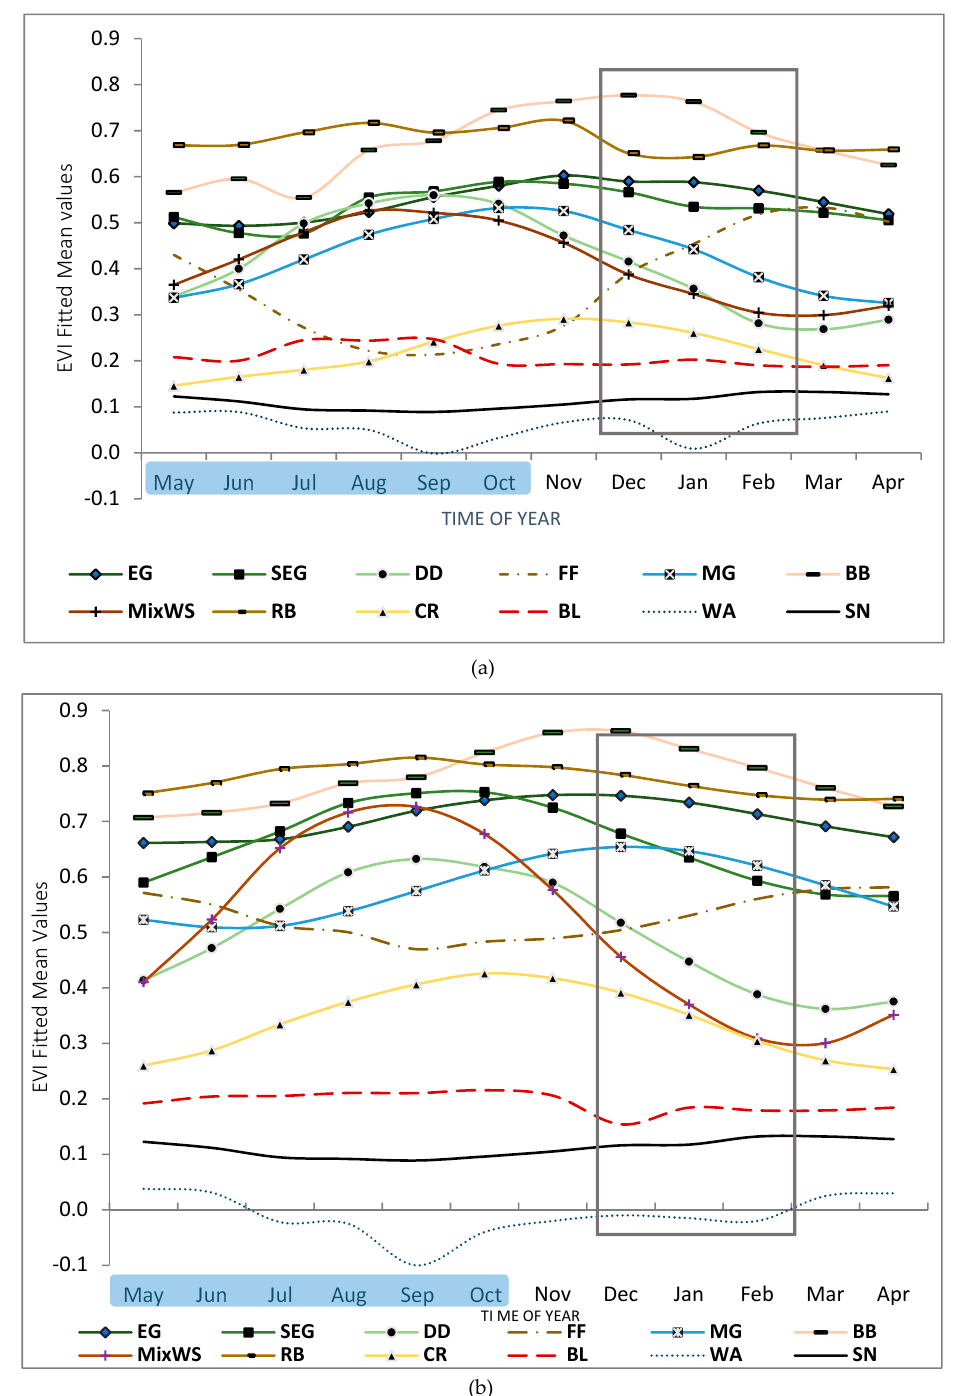
Figure 9. TM and OLI phenology profiles of the individual 12 land cover categories, namely evergreen (EG), semievergreen (SEG), deciduous (DD), flooded forest (FF), mangrove forest (MG), bamboo (BB), Mix wood and shrub (MixWS), rubber plantation (RB), croplands or paddy fields (CR), built-up area (BL), water (WA), and sand or soil (SN) in the LSP and LFP seasons. (a) TM results from the fitted EVI mean phenological behaviors of 12 land cover categories from 2000–2003. (b ) OLI results from the fitted EVI mean phenological behaviors from 2014–2017. The highlighted light blue color indicates the SOS to EOS phase and it is also an indication of the vegetation leaf-flushing season. The highlighted dark box represents the phase of separation of the vegetation index profiles of all 12 land cover categories during the mid-dry LSP phase.